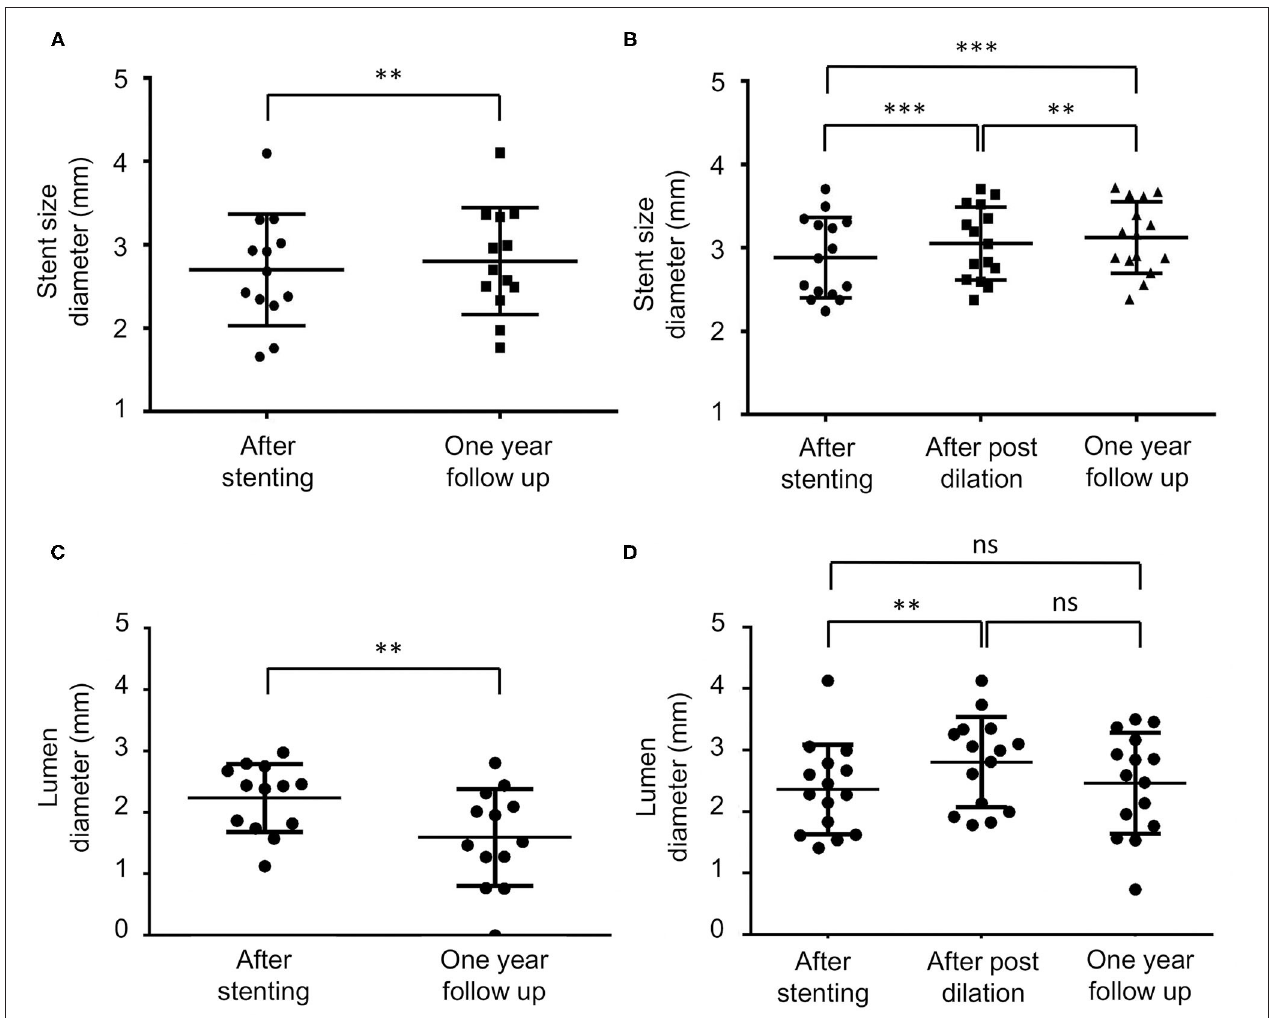
FIGURE 1 | The stent and lumen diameter measurement during the procedure and at 1-year follow-up. ns, non-significant, ** p < 0.01, *** p < 0.001. (A,B) Are the mean stent size in the no post-dilation and post-dilation groups, respectively. In the no post-dilation group, the diameter has a significant increase at a 1-year follow-up (2.70 ± 0.67 vs. 2.80 ± 0.64mm p < 0.01). In the post-dilation group, the stent immediately increased after the post-dilation, and also at a 1-year follow-up (2.89 ± 0.48, 3.05 ± 0.44, and 3.12 ± 0.43mm, p < 0.001, p < 0.01, p < 0.001). (C,D) Are the mean stenosis lumen diameter in the no post-dilation and the post-dilation groups, respectively. In the no post-dilation group, the lumen diameter significantly decreases at a 1-year follow-up ( p < 0.01). In the post-dilation group, immediately after the post-dilation angioplasty, the lumen increased (2.36 ± 0.73 vs. 2.81 ± 0.73mm, p < 0.01). At a 1-year follow-up, the lumen size decreased but did not significantly differ compared with the time when stent was just deployed and immediately after post-dilation (2.36 ± 0.73 vs. 2.46 ± 0.82mm and 2.81 ± 0.73mm, p = 0.88 and